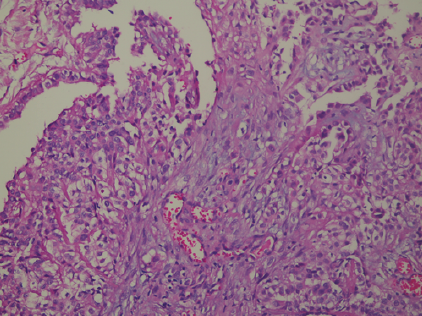
Figure 2: Malignant mesothelioma (H&Ex200).